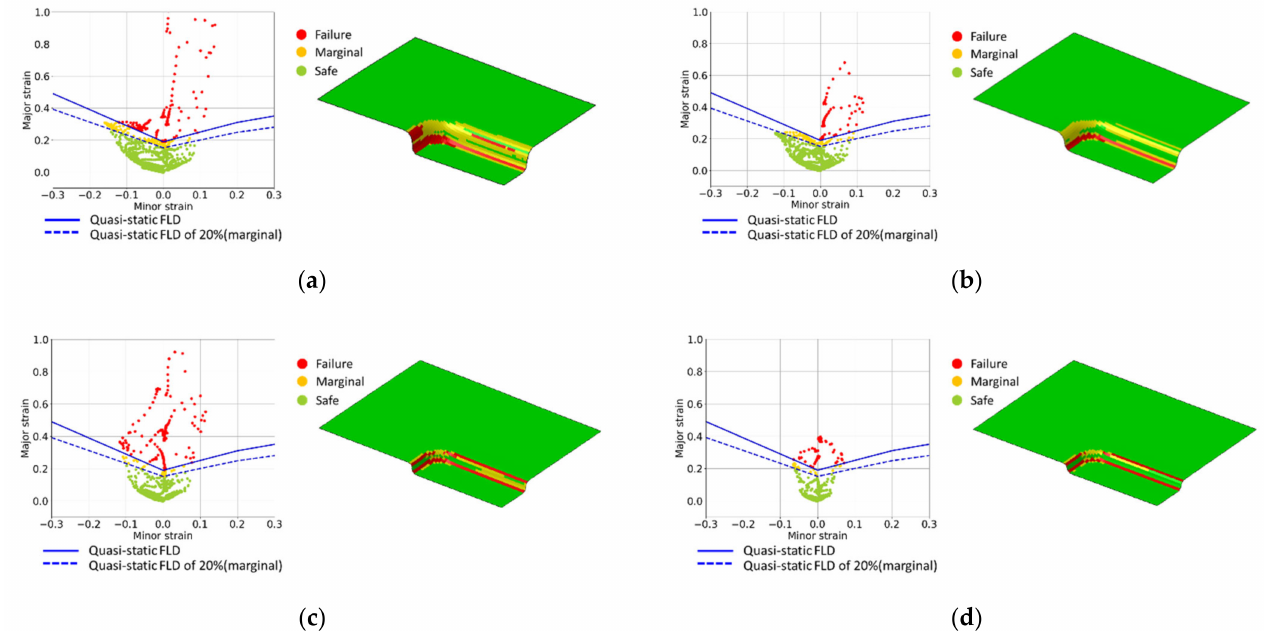
Figure 4. Final thickness of the drawing process for ( a ) CASE 1, ( b ) CASE 2, ( c ) CASE 3, and ( d ) CASE 4.